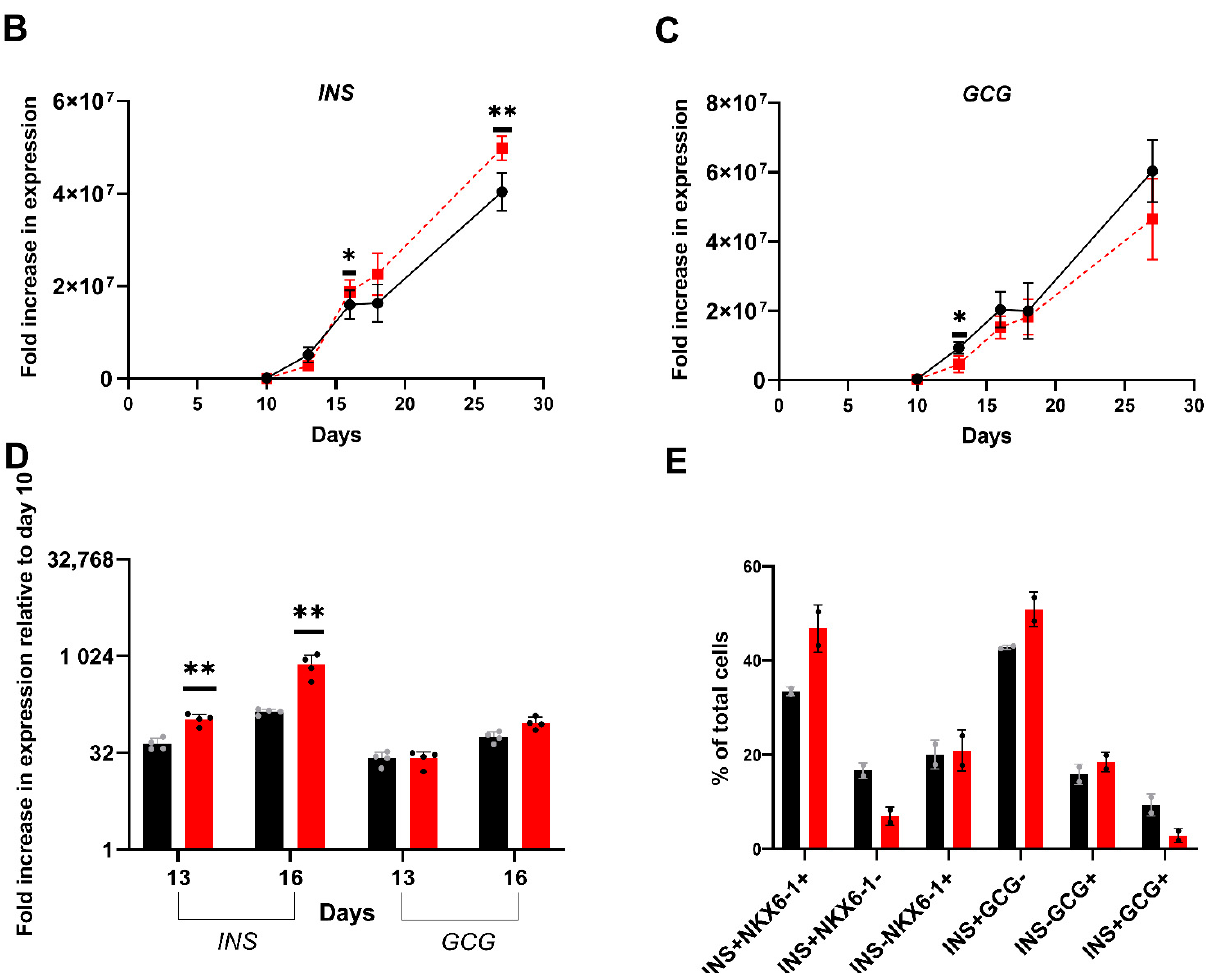
Figure 6. Stage specific differential increase in INS gene expression in cells with the 2.3 kb hemizygous deletion ( A ). Expression of islet specific genes in day 27 islet-like cells generated from hiPSC with the deletion relative to expression in day 27 islet-like cells generated from the parental hiPSC. Results are from four independent differentiations and the error bars show SD. Expression was calculated relative to expression in islet-like cells generated from the parental hiPSC in experiment 1 and results were compared using t-test. ( B , C ). Fold increase in the expression of INS and GCG expression during differentiation of the deletion iPS cell line and the parental iPS cell line towards pancreatic islet-like cells relative to the expression in hiPSCs. Results are from four independent differentiations and the error bars show SD. Expression was calculated relative to expression in parental hiPSC from experiment 1 and results were compared using t -test. ( D ). Fold increase in INS and GCG expression during the endocrine progenitor stage (day 13 and 16) relative to expression in pancreatic progenitors (day 10) from the parental and deletion cell lines. ( E ). Flow cytometry analysis of day 27 islet-like cells. Results are from two independent differentiations and error bars show SD. * p < 0.05, ** p <